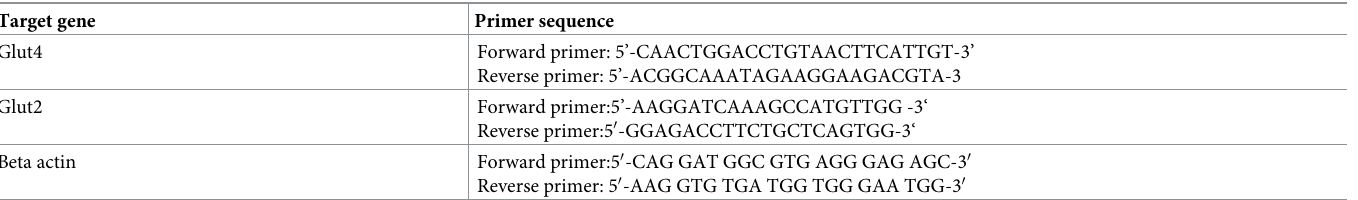
Table 1. The primer sequence of the studied genes. Target